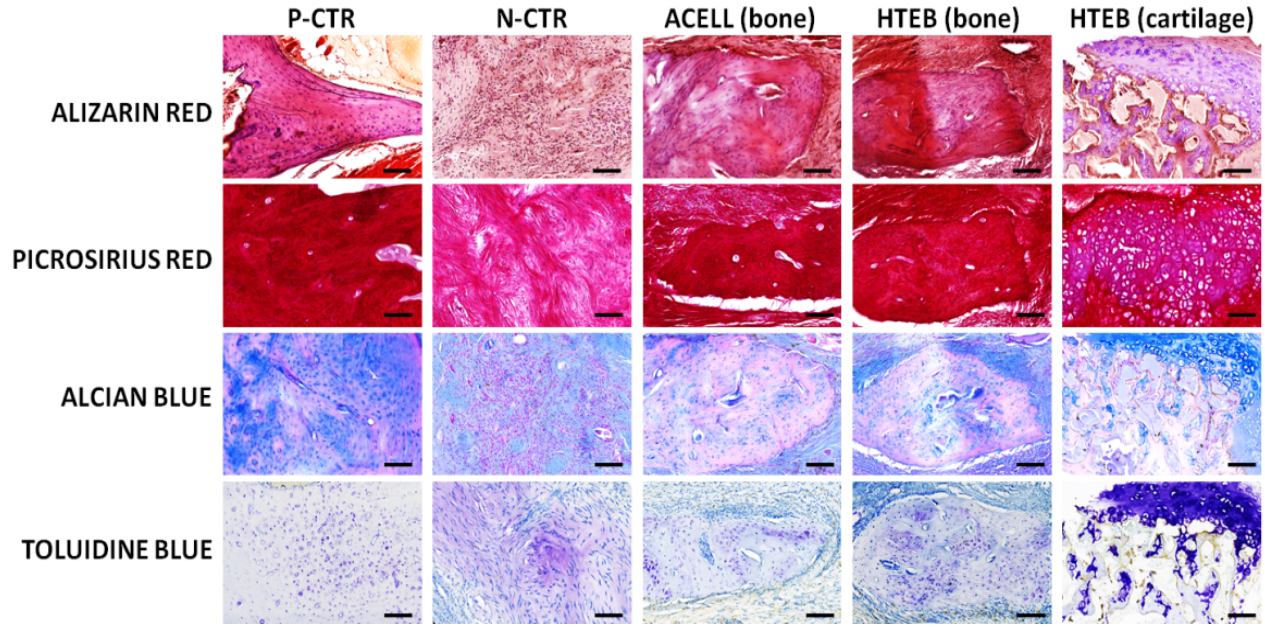
Figure 5. Analysis of ECM components at the defect area of each group of animals included in the study, as determined by histochemistry using alizarin red, picrosirius red, alcian blue, and toluidine blue. P-CTR: native normal animals, used as positive controls; N-CTR: animals subjected to surgical removal of a fragment of the right mandible, used as negative controls; ACELL: animals subjected to surgical removal of a fragment of the right mandible and implant of a nanostructured fibrin–agarose biomaterial; HTEB: animals subjected to surgical removal of a fragment of the right mandible and implant of a nanostructured human tissue-engineered bone substitute. Scale bars: 100 µm.